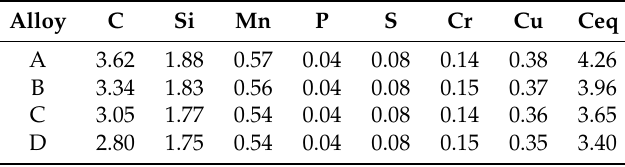
Table 1. Chemical composition (wt %) and carbon equivalent (Ceq = %C + %Si/3 +